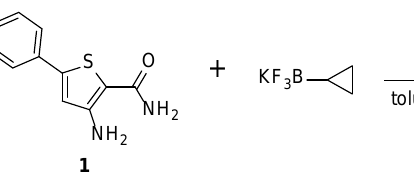
Figure 2. Examples of marketed boron-containing drugs.